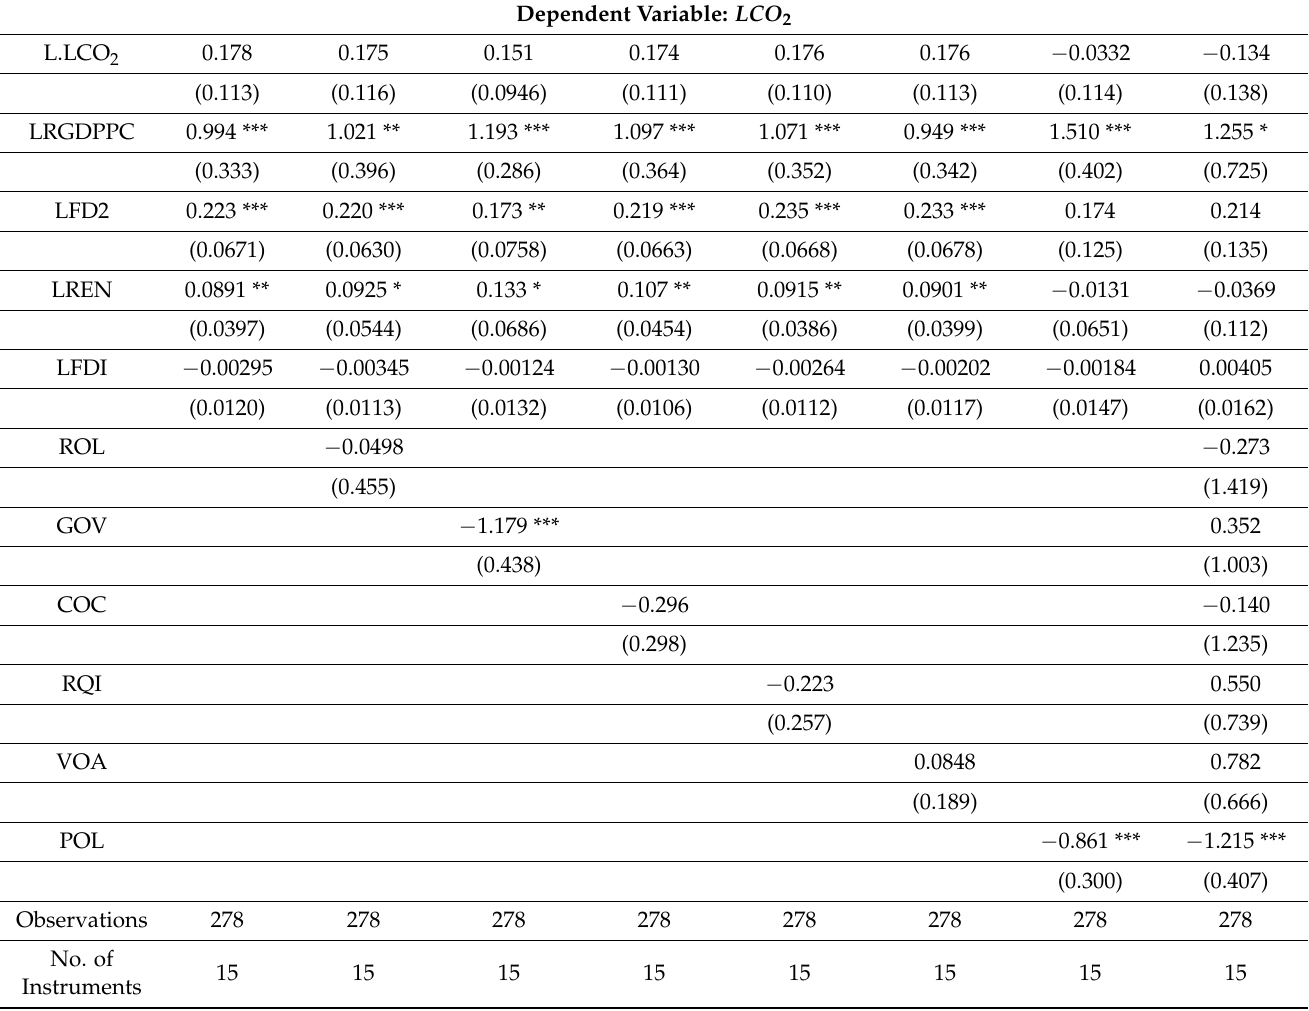
Table 5. Financial development by (ii) domestic credit provided by the financial sector (% of GDP)